Question: State the chart type depicted above.
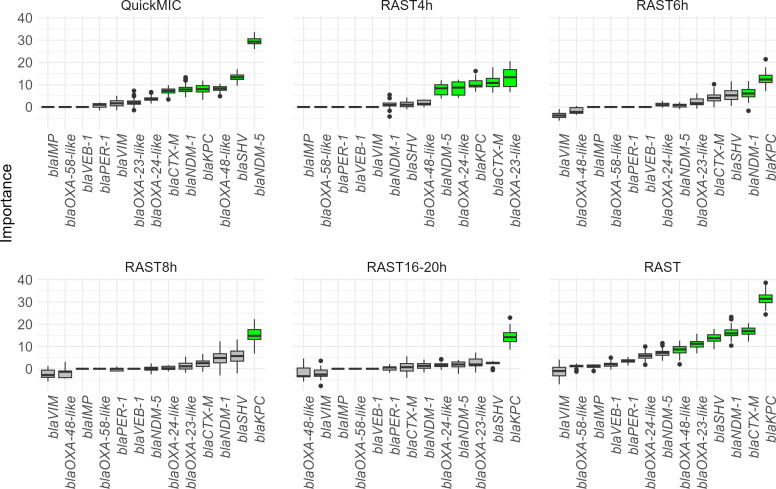
Answer: box